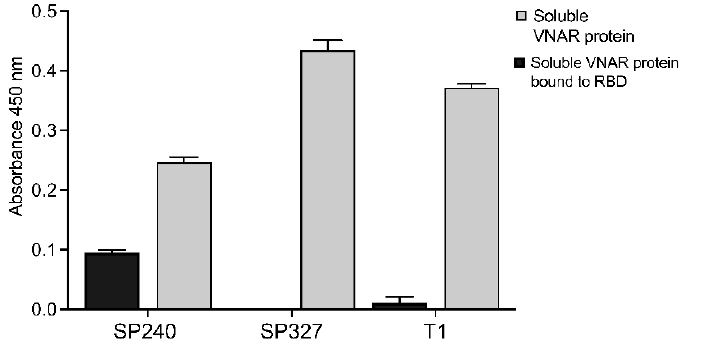
Figure 1. Assessment of VNAR SARS-CoV-2 binders as recombinant proteins and their recognition ability. The VNAR SARS-CoV-2 binders were obtained as soluble proteins at a small scale and their binding ability to the RBD from spike protein was evaluated by ELISA. Direct ELISA was performed to estimate the VNAR soluble protein (grey bars) obtained from an E. coli BL21 (DE3) expression system. The highest protein product was observed for VNAR SP327 and T1, and the lowest for VNAR SP240. However, the highest binding capacity to the RBD from the spike protein was shown by the VNAR SP240 in an indirect ELISA (black bars). We infer that other proteins might have con- tributed to the signal displayed for soluble proteins VNAR SP327 and T1. Indeed, the best relation- ship between expressed protein and target recognition was shown by VNAR SP240.